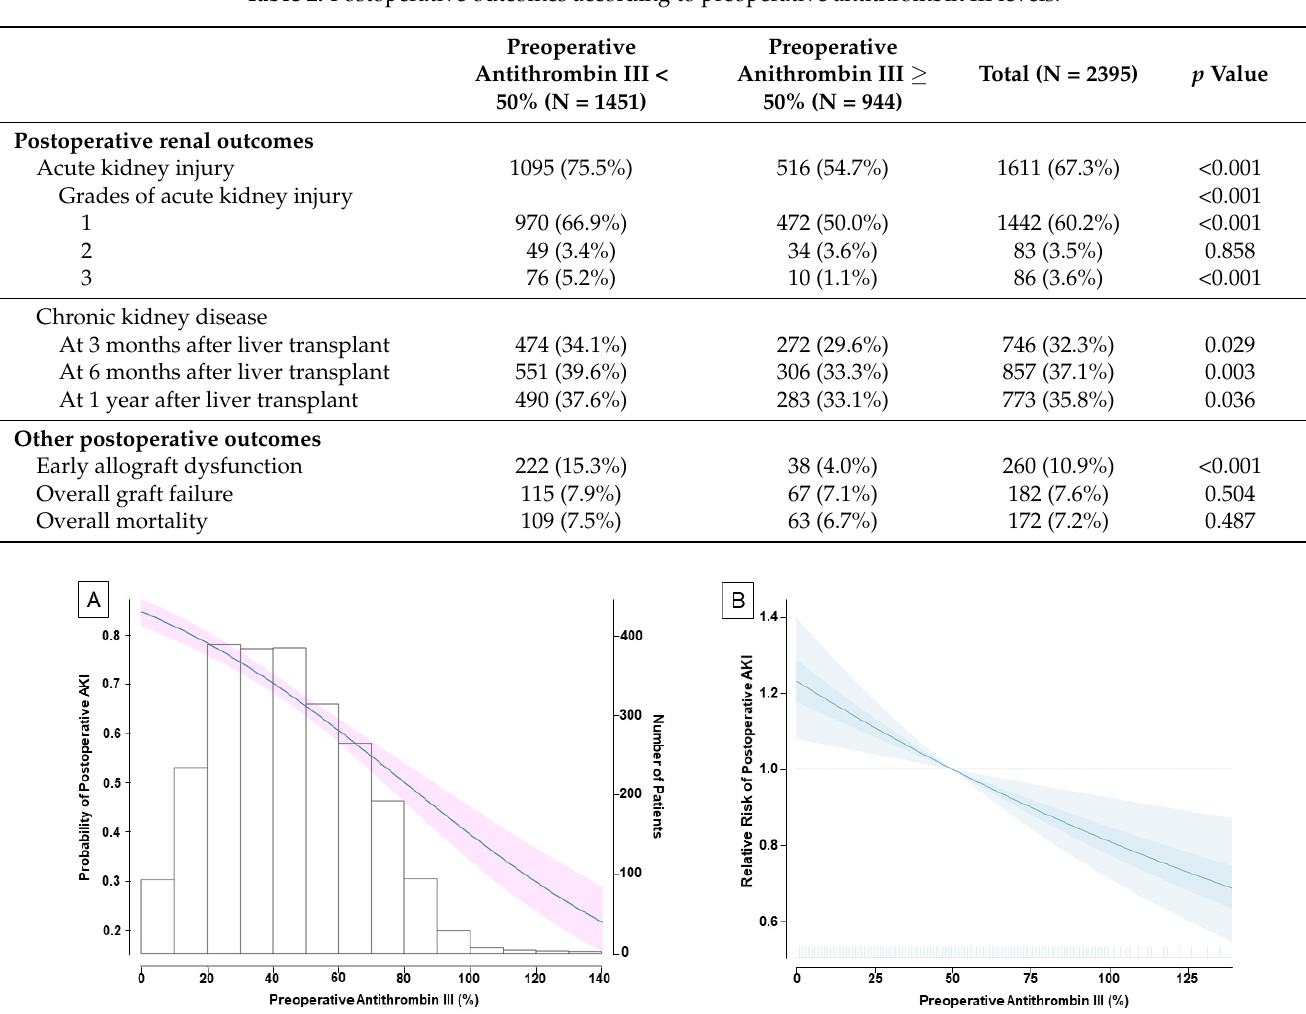
Table 2. Postoperative outcomes according to preoperative antithrombin III levels.